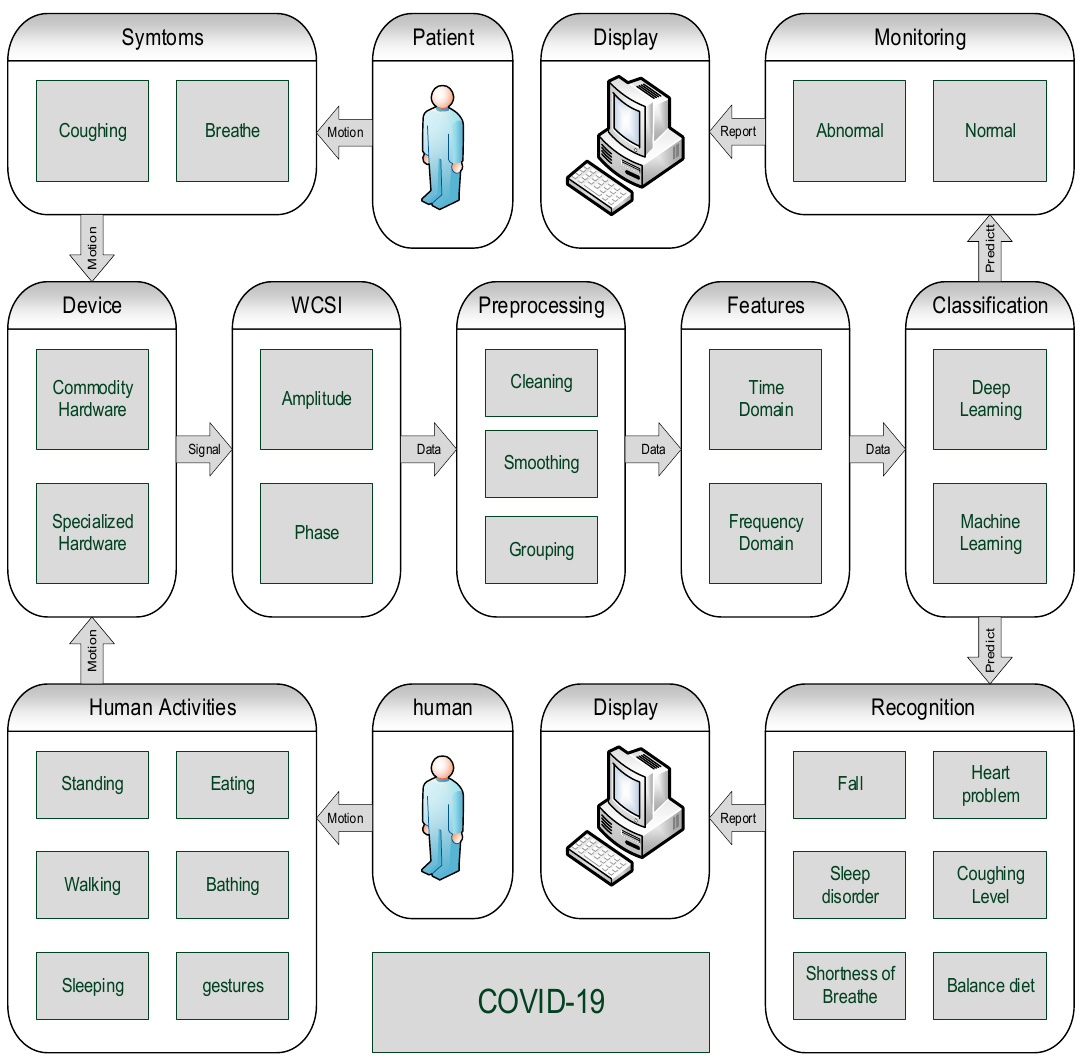
Figure 3. Non-contact sensing platform for diagnosis and